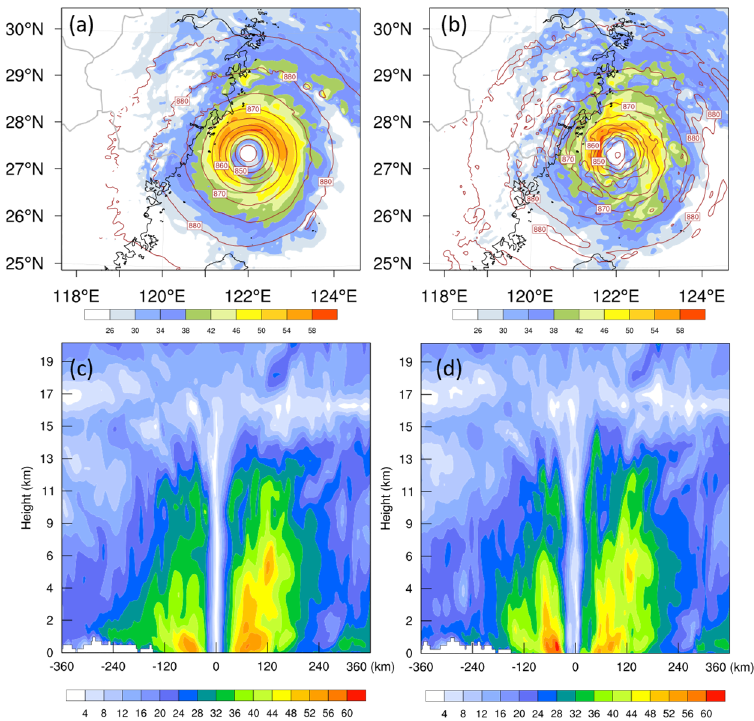
Figure 4. ( a , b ) Horizontal wind speed (shaded, units: m/s) and pressure (contours, at 5 hPa intervals) at 1 km height at 1200 UTC, 9 August in experiments. ( a ) CNTL, ( b ) Z − DA. ( c , d ) East − west vertical cross − section of horizontal wind speed (shaded, units: m/s) through vortex center in experiments. ( c ) CNTL; ( d ) Z − DA.